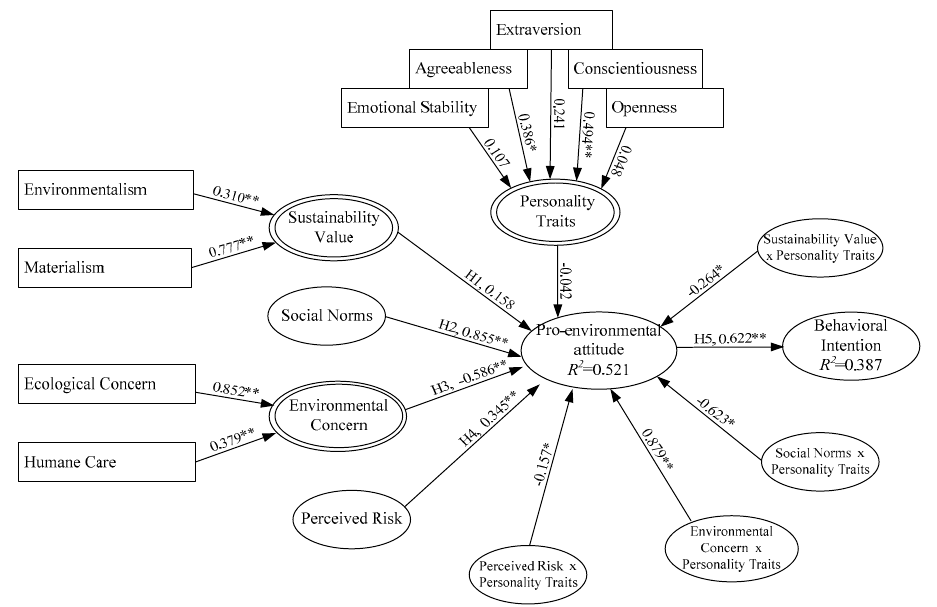
Figure 2. Path relations of the proposed model (including interaction effects) . * p < 0.05; ** p < 0.01.